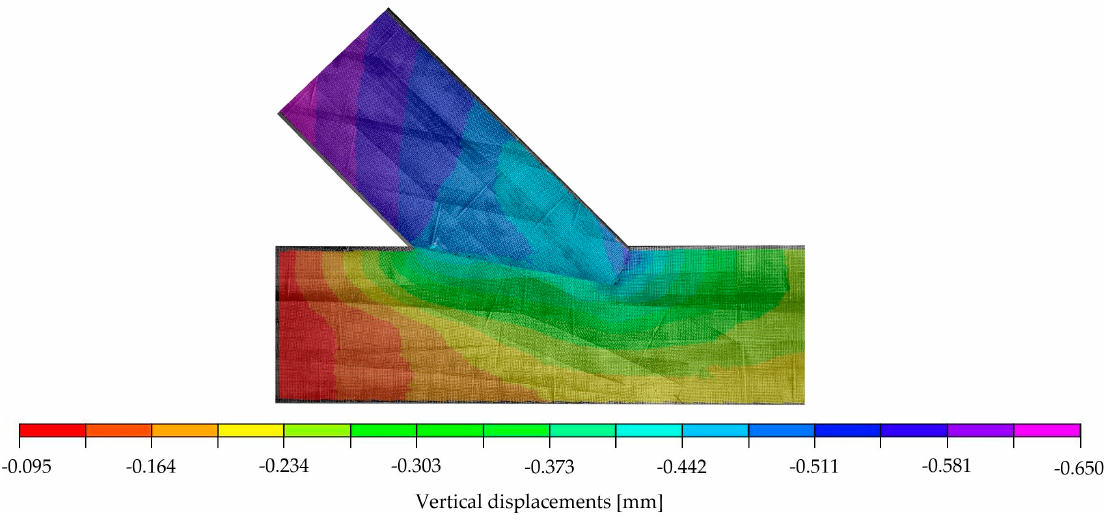
Figure 5. DIC-vertical displacements on the surface of specimen A_5 at 70.1 kN.